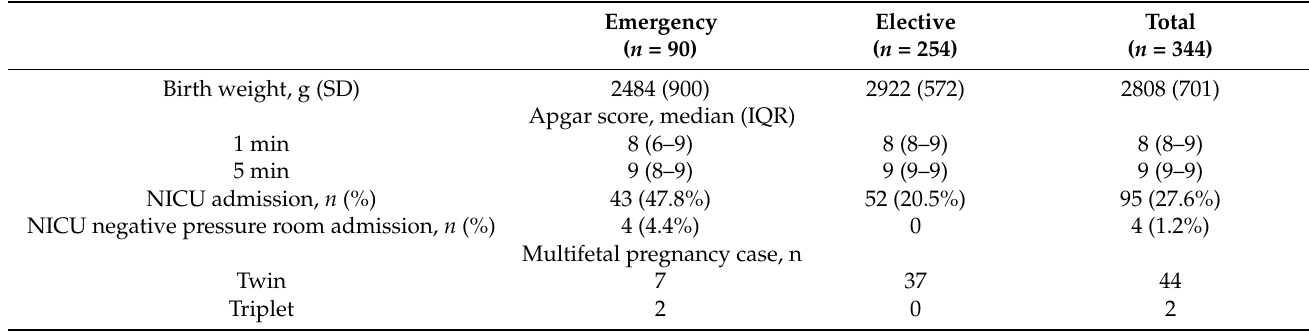
Table 3. Neonatal outcomes.